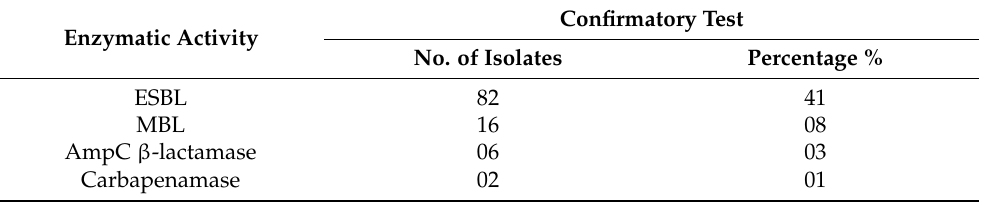
Table 2. Table presenting the percentage of enzymatic activities shown by bovine fecal E. coli iso- lates.